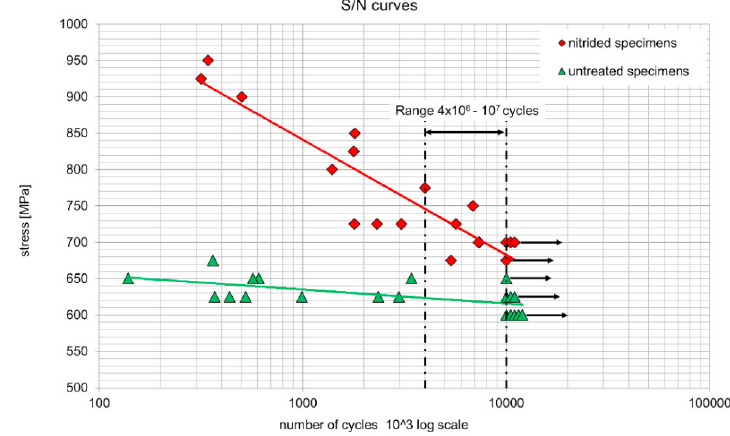
Figure 8. S/N curve of untreated and nitrided specimens.